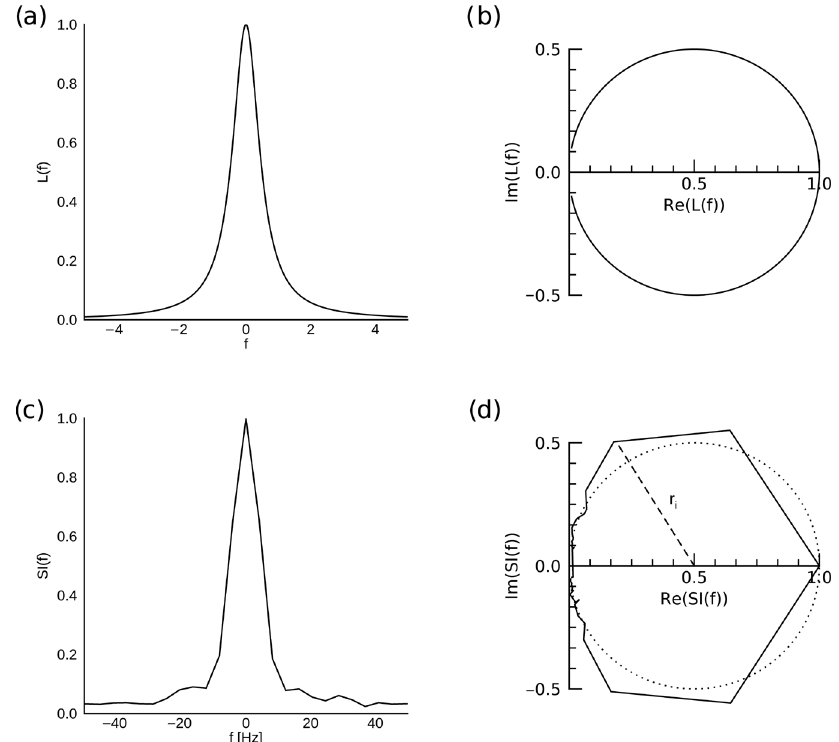
Figure 3. Illustration of DISPA analysis. A spectral peak with an ideal Lorentzian shape L(f), normalized so that the maximum value is 1 ( a ) is represented by a circle of radius 0.5 centered on (0.5, 0) in the complex plane ( b ). Spectral intensity SI(f) of actual water resonance from a voxel in the agar compartment of the phantom, reconstructed with CS at R = 10, is shown in ( c ), and its representation in the complex plane is shown in ( d ), with the ideal Lorentzian shape represented by the dotted circle. A radius r i corresponding to one of the spectral bins is shown by the dashed line. The phasing of the resonance was performed, and the baseline was removed in each voxel. TRD was calculated and averaged over the two